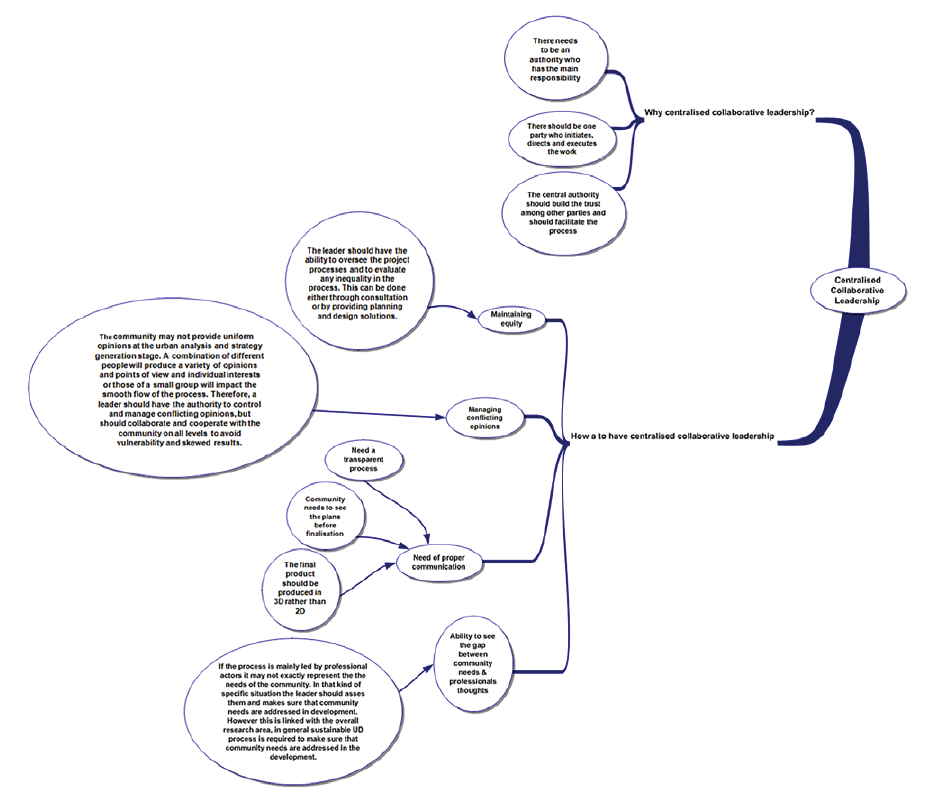
Figure 4. Mind map for the CSF ‘Centralised collaborative